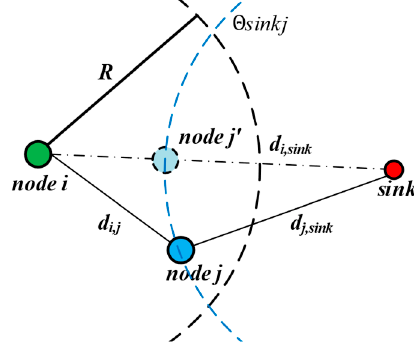
Figure 1. The forward